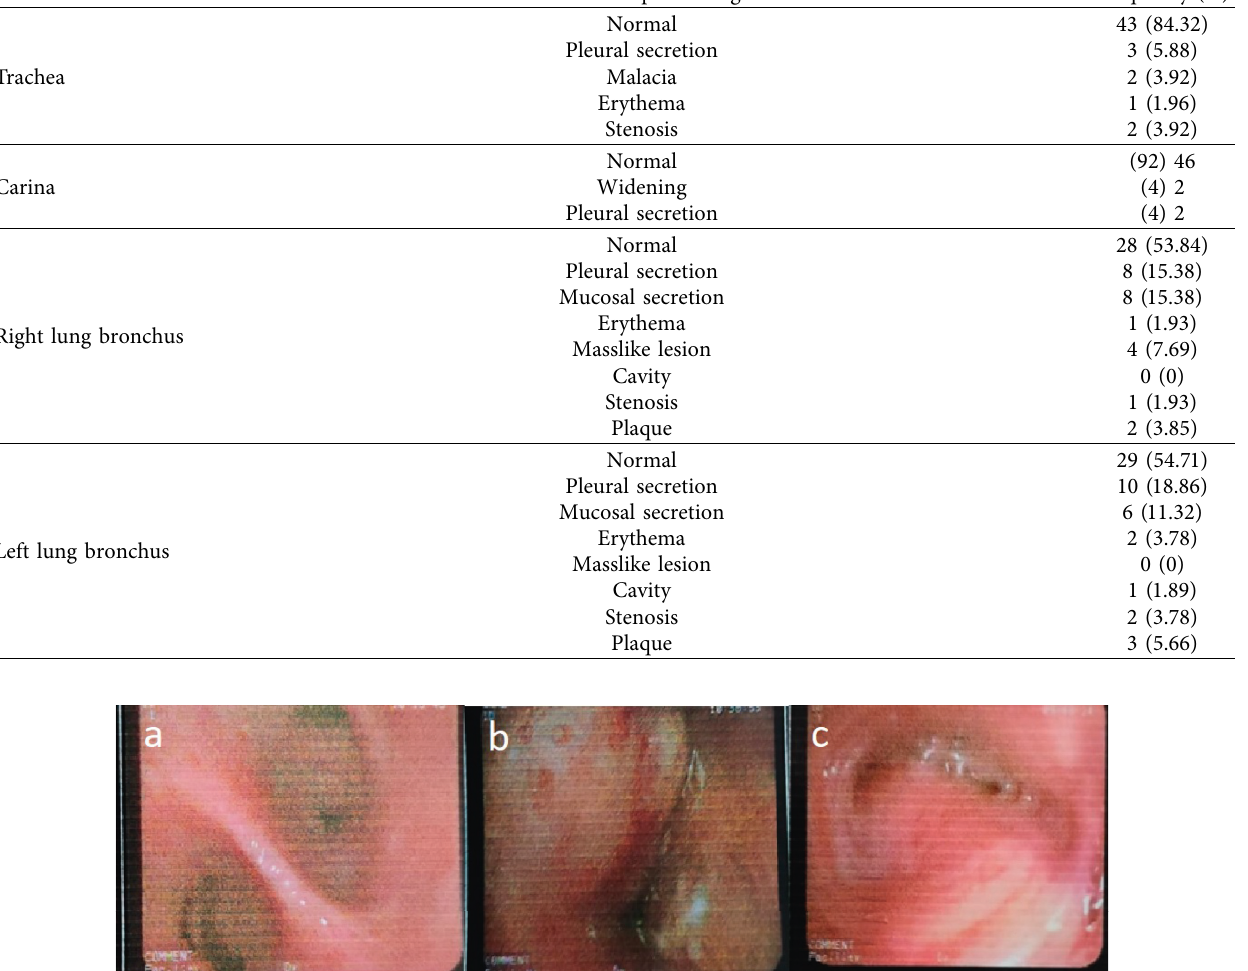
Figure 2: Bronchoscopic view of Lophomonas -positive patients. (a) Purulent secretion view in the carina. (b) Masslike lesion view in the right lung bronchus. (c) Mucosal secretions view in the left lung bronchus.